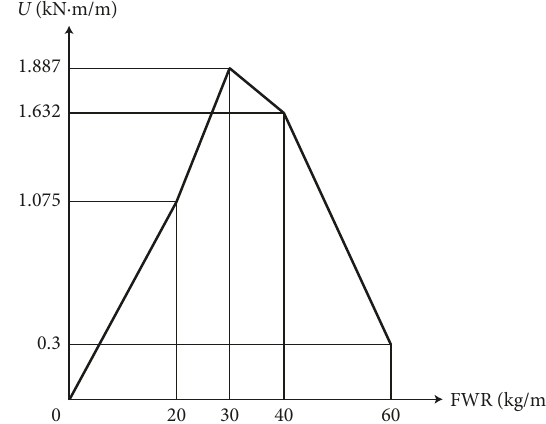
Figure 1: Energy dissipated during loading and unloading for cylindrical specimens with different FWRs [4].